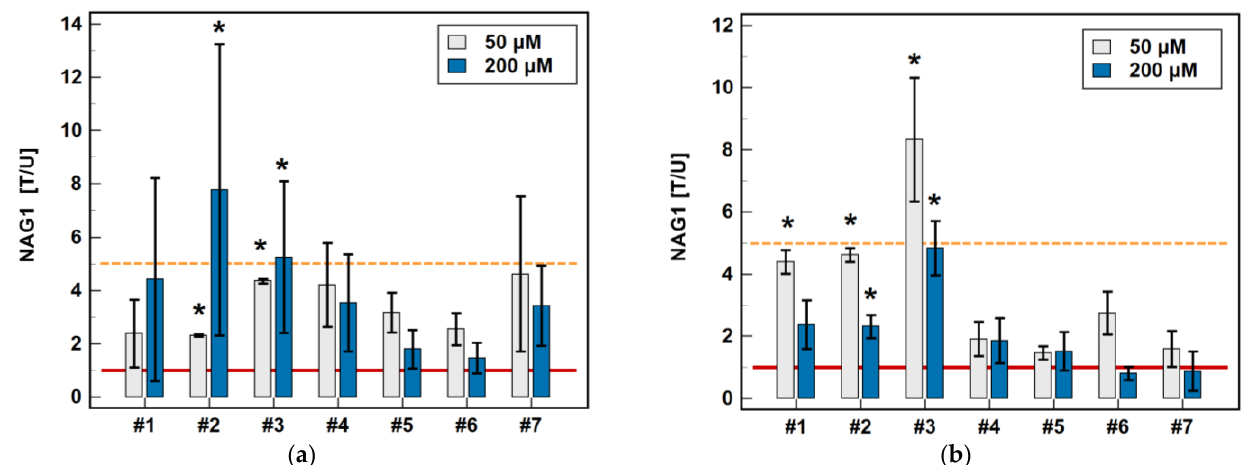
Figure 11. Effect of oxicams on NAG1 protein expression in ( a ) HCT 116 cells and ( b ) HT-29 cells. The bars represent the mean ± SD (whiskers) of the expression ratio between cells treated with 50 or 200 μM oxicams for 48 h, and the corresponding untreated controls [T/U]. The significant differences between the expressions in the treated and untreated cells, analyzed using a t -test for one mean, are indicated by asterisks (*). An expression ratio of 1 (no change) is indicated by a red solid reference line, and an expression ratio of 5 (upregulation) is indicated by an orange dashed reference line. Compound # 6 denotes piroxicam, and # 7 denotes meloxicam.